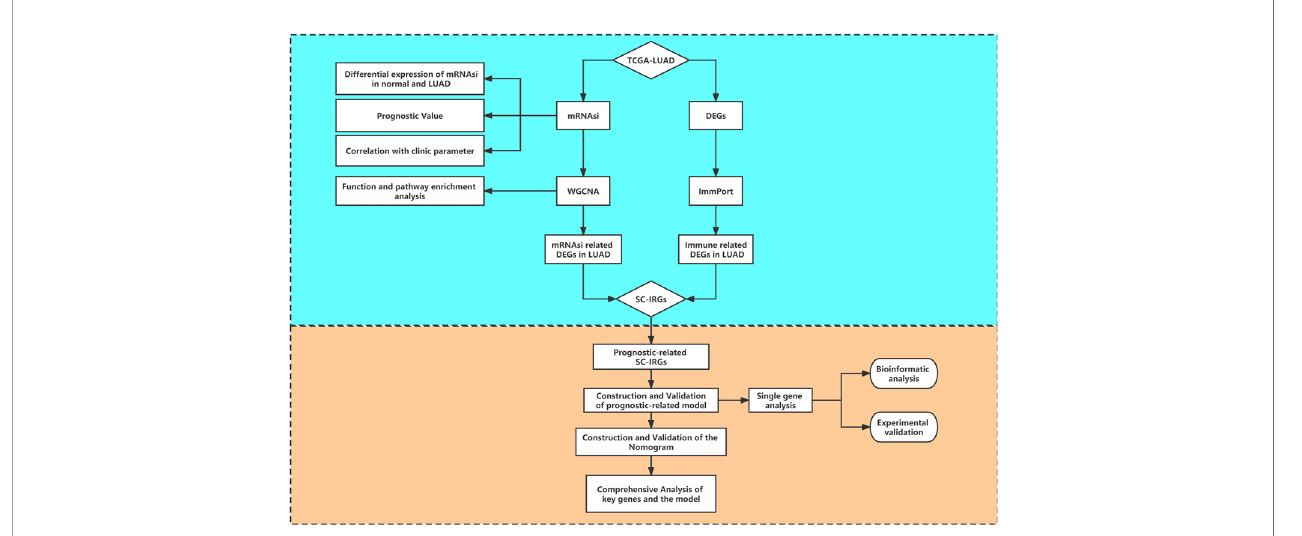
FIGURE 1 | Flow diagram of the